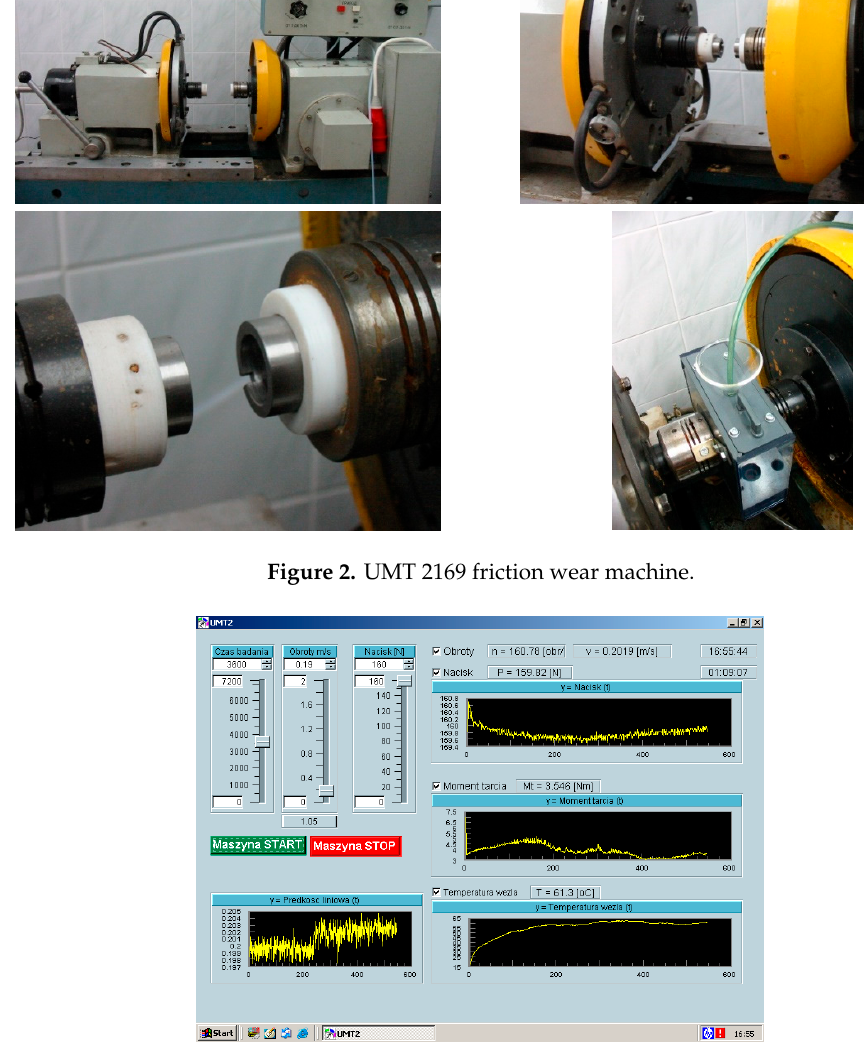
Figure 3. Machine control panel.